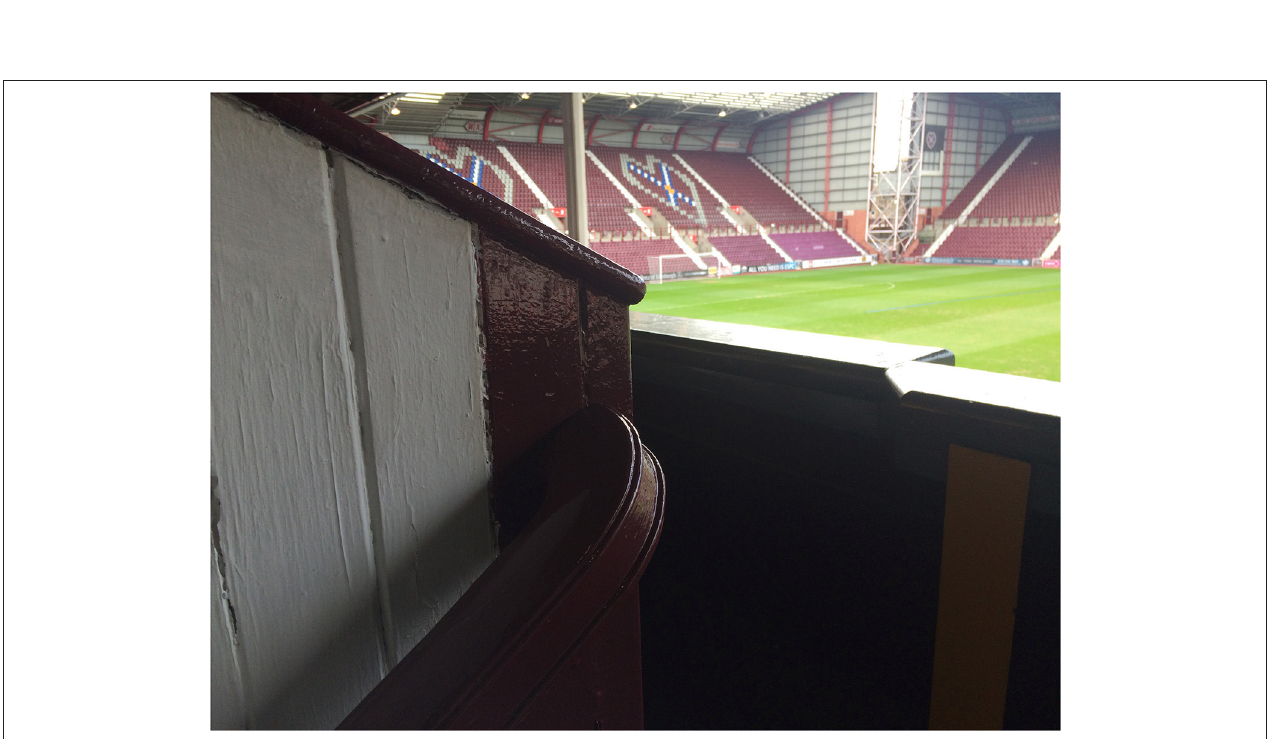
FIGURE 4 | Detail from the wooden railing at the old main stand at Tynecastle Park (Credit: Hans K. Hognestad).